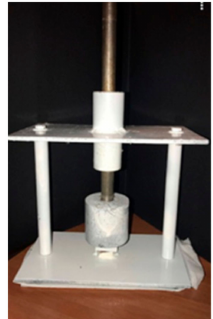
Figure 1. Specially designed device for applying pressure during cementation.